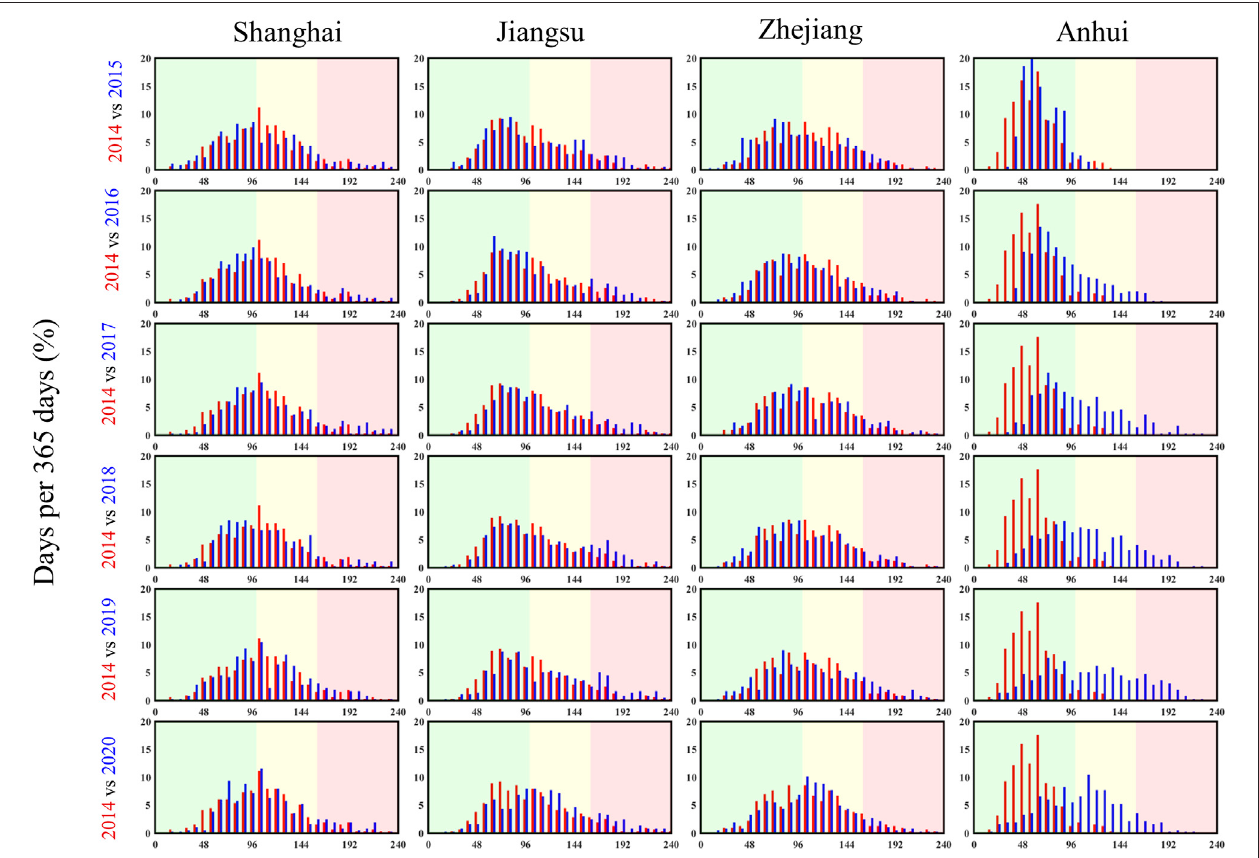
FIGURE 2 | Frequency distribution of the MDA8 O 3 concentration in the YRD region during the study period. Red bars represent the values of 2014. Blue bars indicate the values in the other year during 2015 – 2020. The colored shaded areas show different pollution levels according to the National Ambient Air Quality Standard of